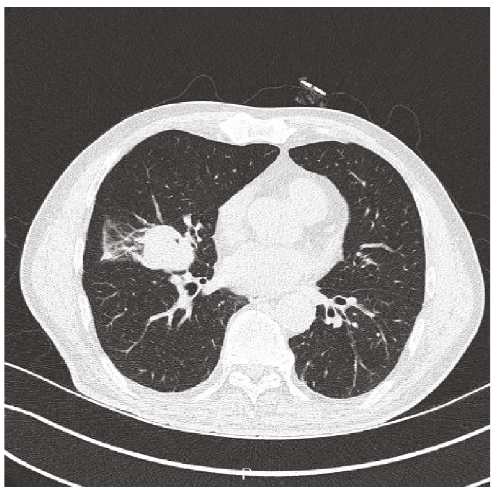
Figure 1: CT imaging of the chest demonstrated a density soft tissue mass in the lateral segment of the right middle lobe.